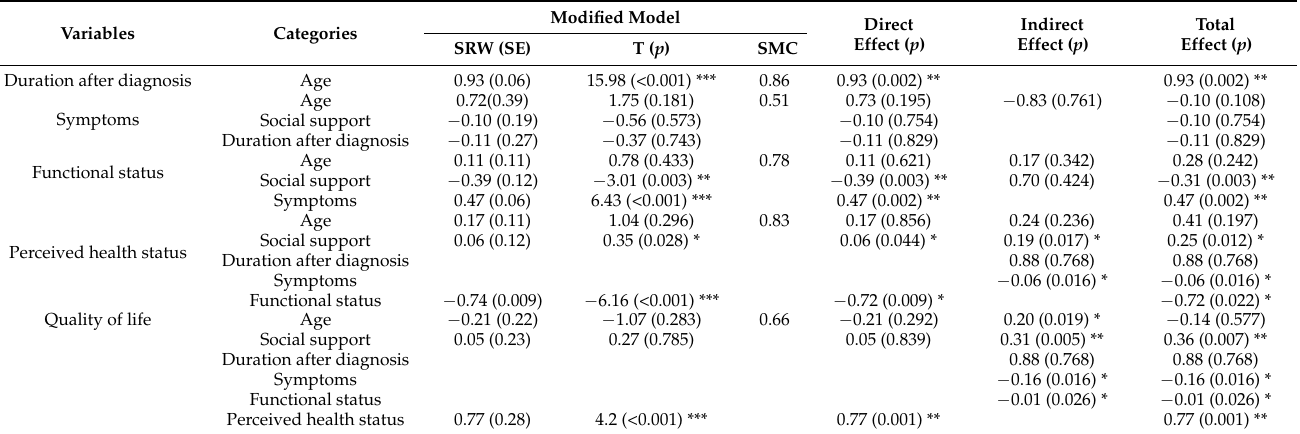
Table 4. Direct Effect, Indirect Effect, and Total Effect in Modified Path Model (N =